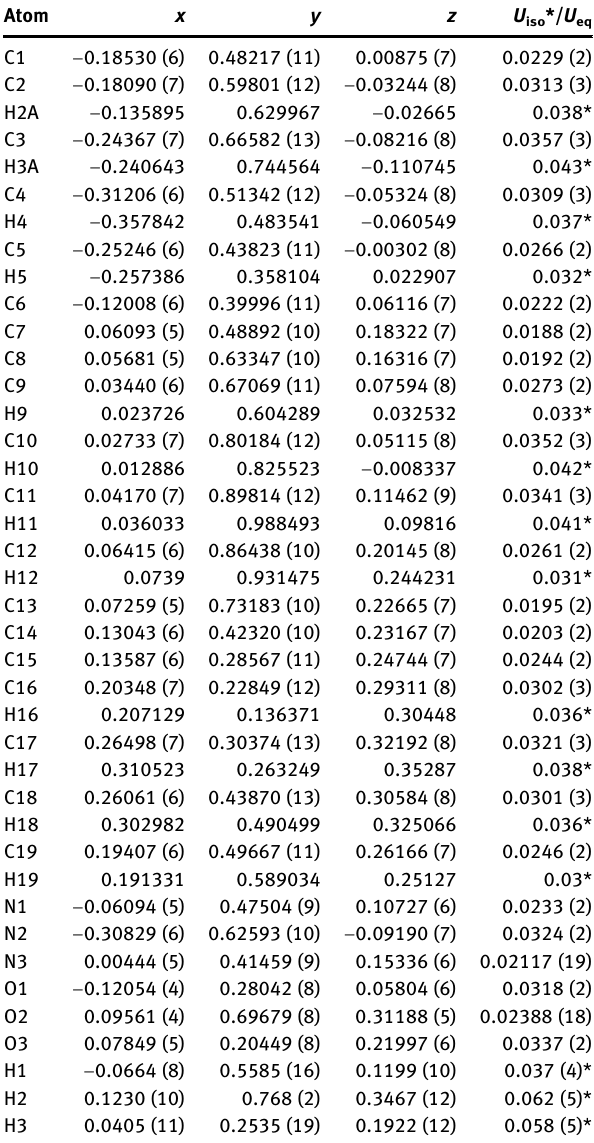
Table  : Fractional atomic coordinates and isotropic or equivalent isotropic displacement parameters (Å 